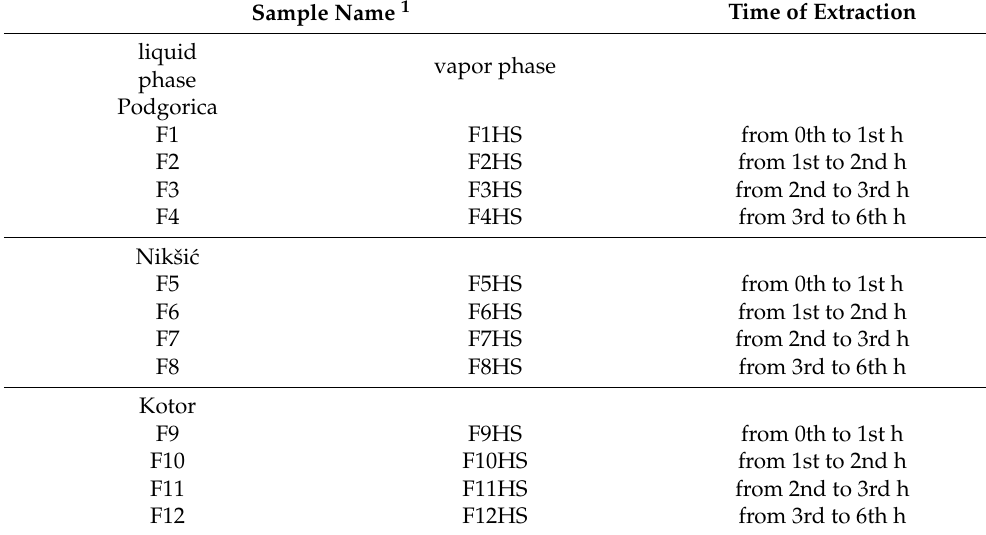
Table 1. A total of 12 essential oil (EO) samples obtained for each of the 3